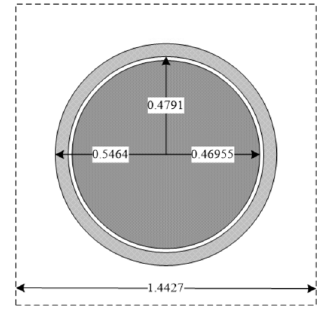
Fig.1. Geometry of the TMI-1 pin cell (unit: cm).